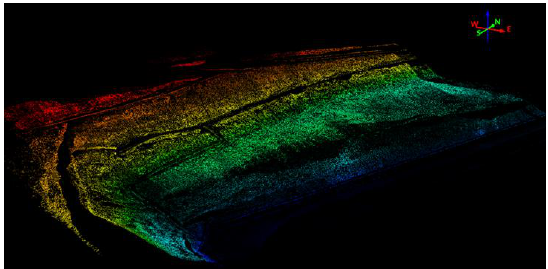
Figure 10. Filtered mobile laser scanning data